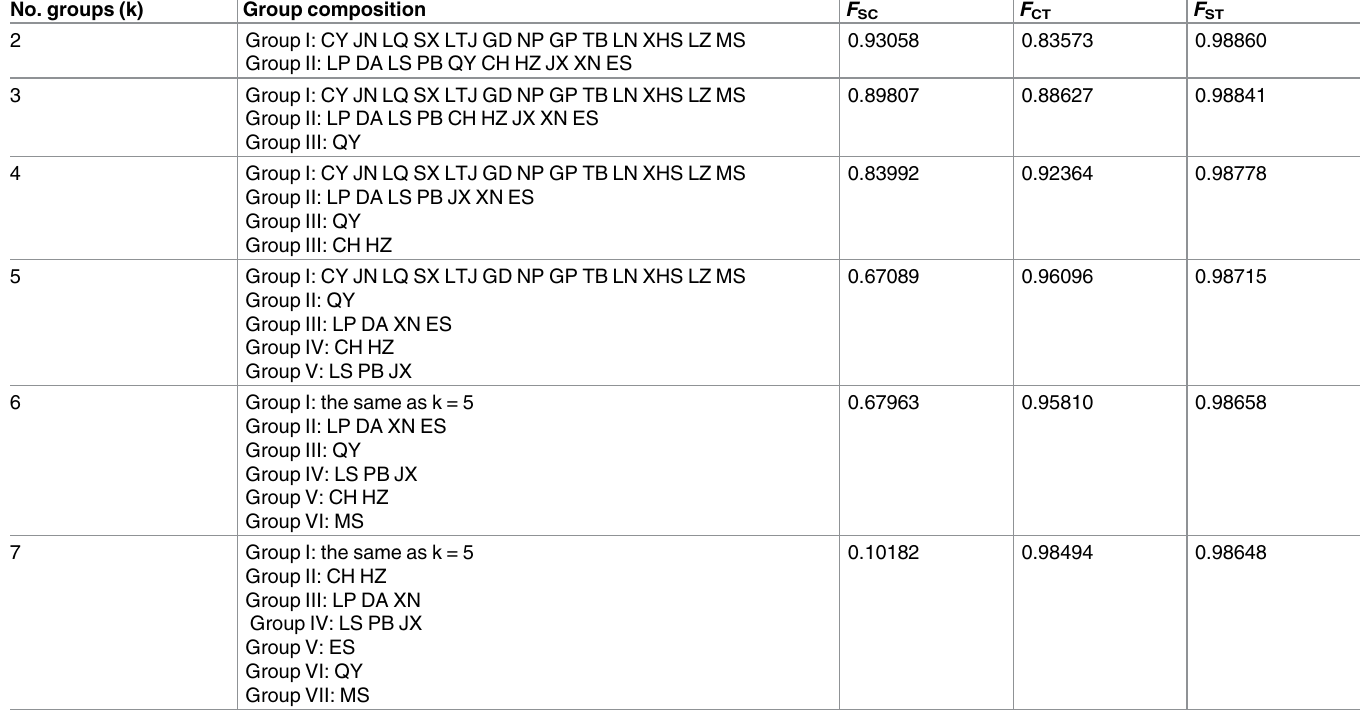
Table 3. Comparison of group composition and fixation indices for groupings of the 23 Chinese Bretschneidera sinensis populations detected by SAMOVA. No. groups